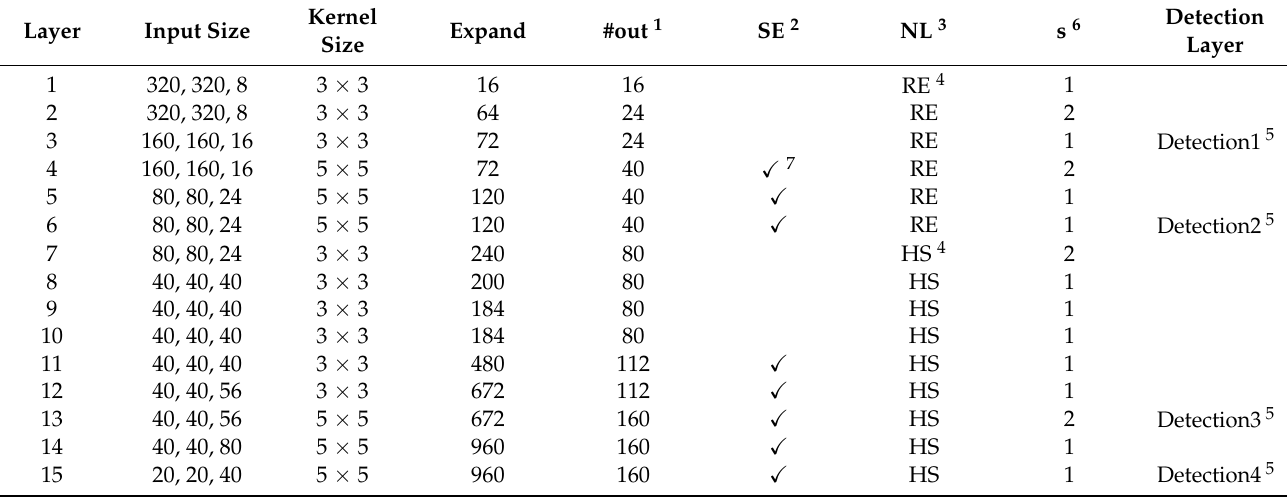
Table 2. Parameters of MobileNetV3-Large network architecture and corresponding prediction